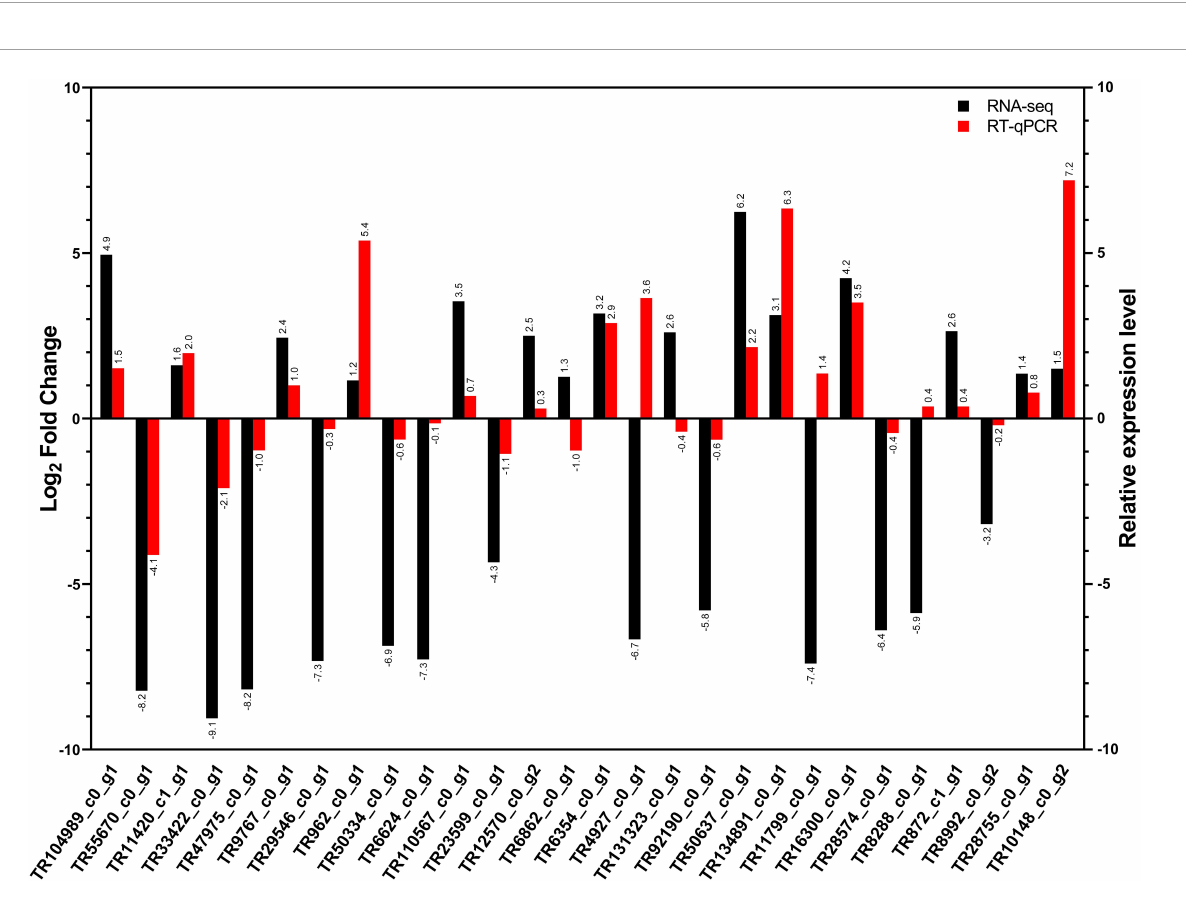
FIGURE8 RNA-seq and RT-qPCR-based comparative expression analysis of 28 candidate genes of whiteflies ( Bemisia tabaci , Asia II, and MEAM1) in response to CLCuMuV infection at 6 and 12 h. Each experiment was replicated with three independent biological replicates and three technical replicates were included per biological